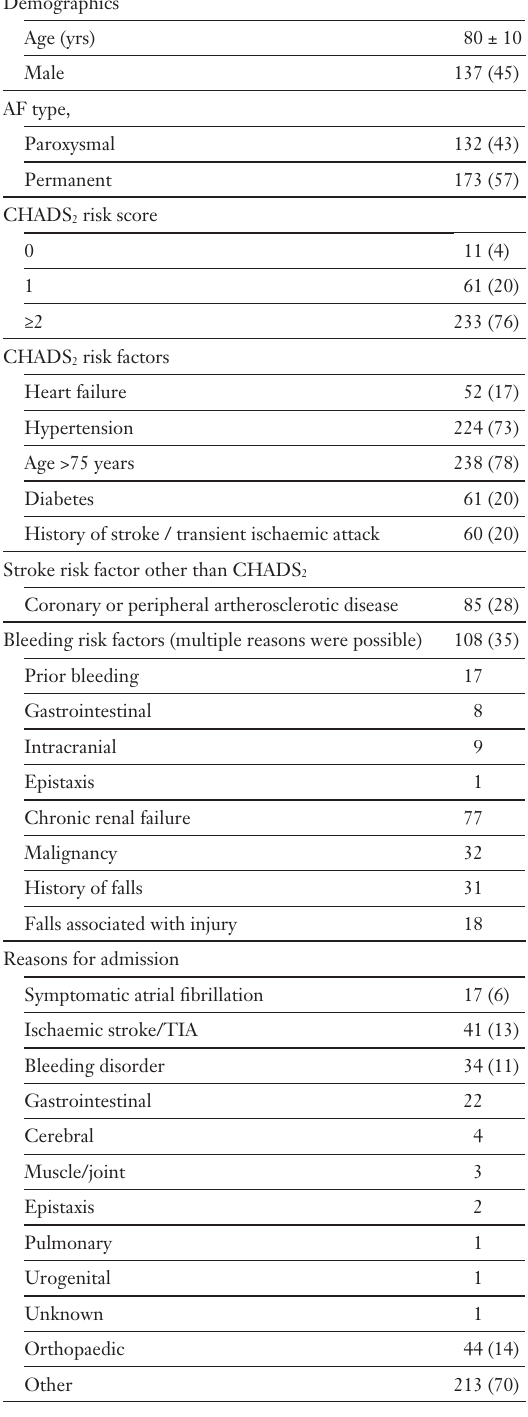
Baseline characteristics, n =